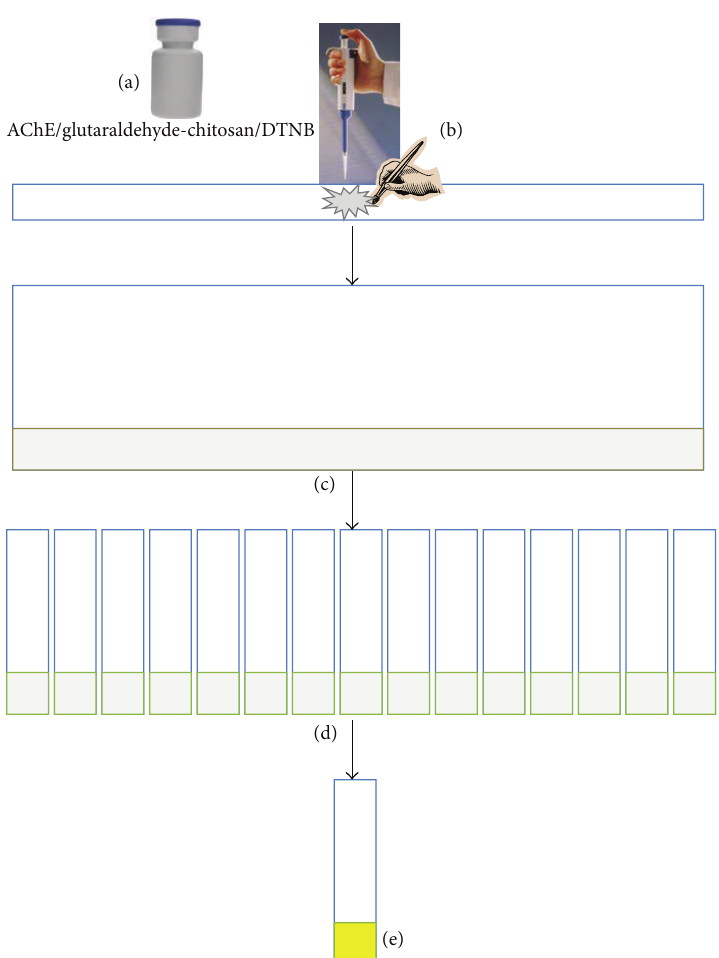
Figure 3: Schematic representation of biosensor support construction. (a) The gel formulation that contains AChE/glutaraldehyde- chitosan/DTNB mixture. (b) The AChE/glutaraldehyde-chitosan/DTNB was directly applied on Canson papers and dried at 37 ∘ C for 15min. (c) The bioactive strip-based sensors were fixed on a Canson paper as a support. (d) Paper sheet was cut to 1 × 10 cm strips. (e) Paper strip after dipping in ATChI solution and incubation at 37 ∘ C for 5 min for yellow color